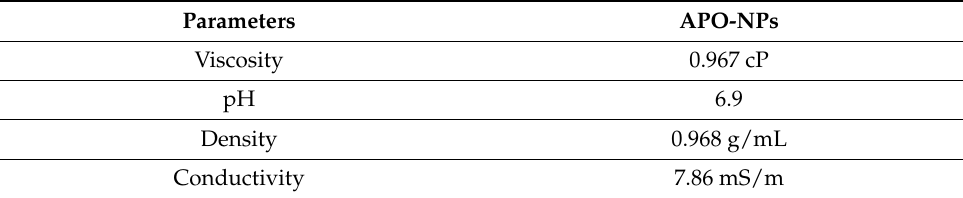
Table 2. Physicochemical parameters of